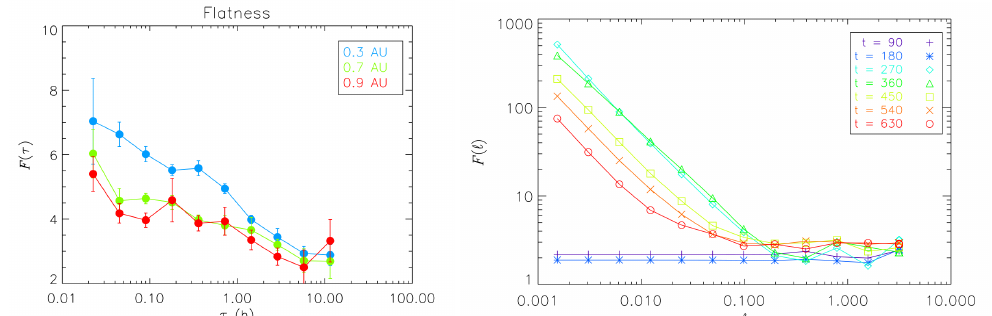
Figure 10. Composite figure that reproduces Figures 2d and 7 of Bruno et al. (2014) [48]. In the left panel the flatness of the density fluctuations at heliocentric distances r = 0.3 AU, r = 0.7 AU and r = 0.9 AU is plotted as a function of time lag τ . In the right panel , the flatness of density fluctuations derived from simulation results as a function of length-scale intervals is plotted at different simulation